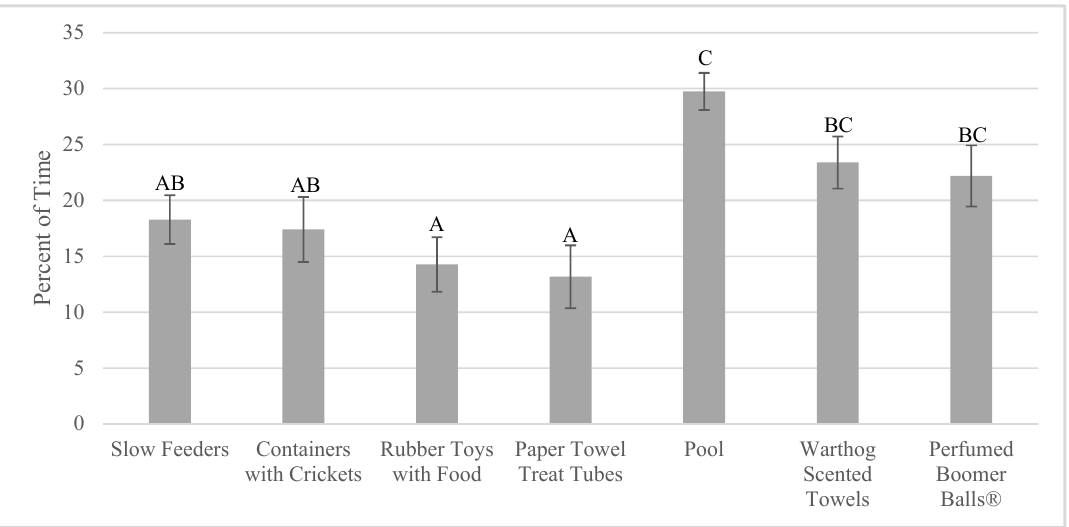
Figure 5. Percent of time locomoting when each enrichment item was available (mean ± SE; n = 4). Significant pairwise comparisons ( p < 0.05) are noted on the graph with different uppercase letters. Pairwise comparisons can be found in Table S7.